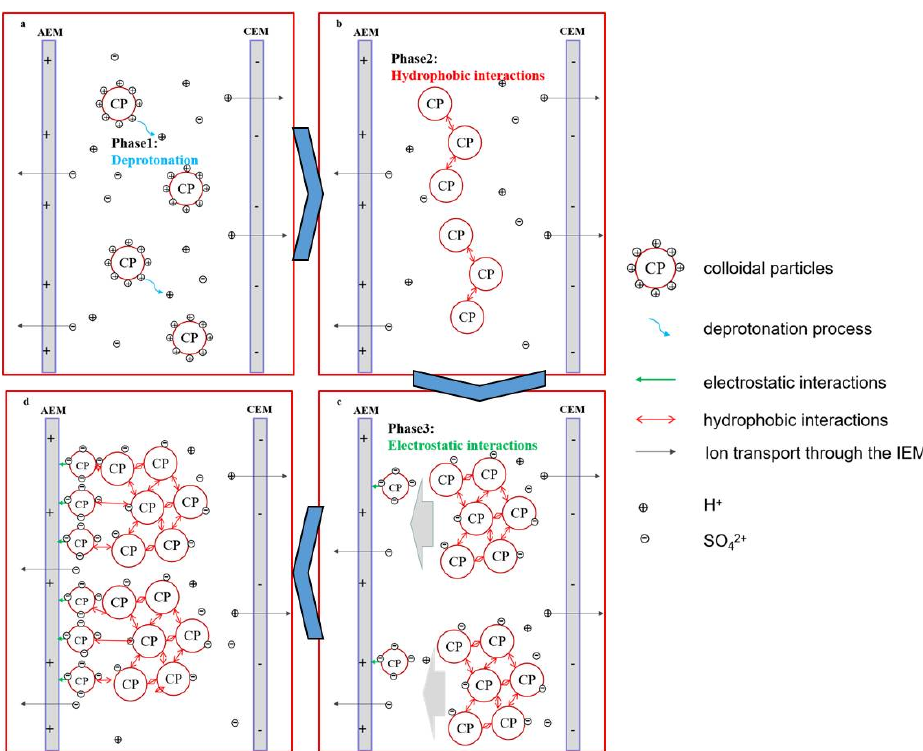
Figure 8. Proposed fouling mechanism of AEM and CEM during electrodialysis deacidification. ( a ) deacidification; ( b ) hydrophobic interactions; ( c ) electrostatic interactions; ( d ) deterioration. At the initial stage (deacidification), it is mainly the acid transport process. The pro ‐ ton (H + ) ions were transported from CEM, while the corresponding anions (SO 42+ and so on) were transported from AEM. Subsequently, with the loss of proton ions in the bulk solution, the proton (H + ) ions on the charged surface of colloidal particles were dissociated into the solution [12,13]. As the zeta potential approaches zero, the colloidal stability of the colloid particles gradually decreases, as shown in Figure 8a.